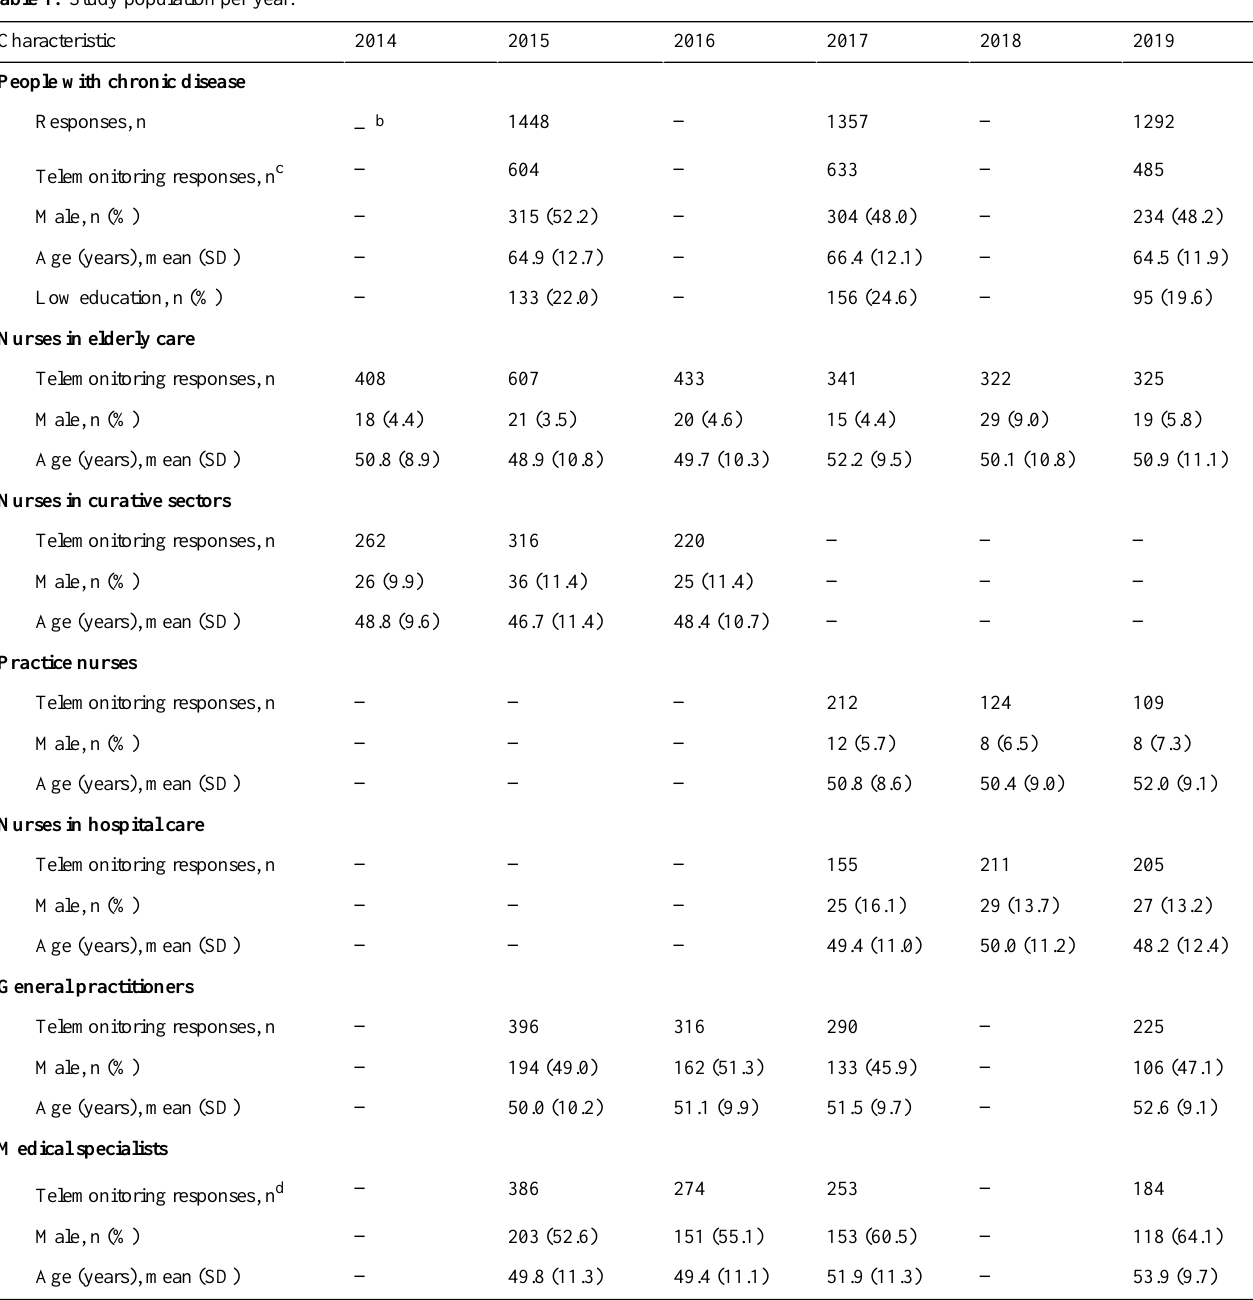
Table 1. Study population per year. a